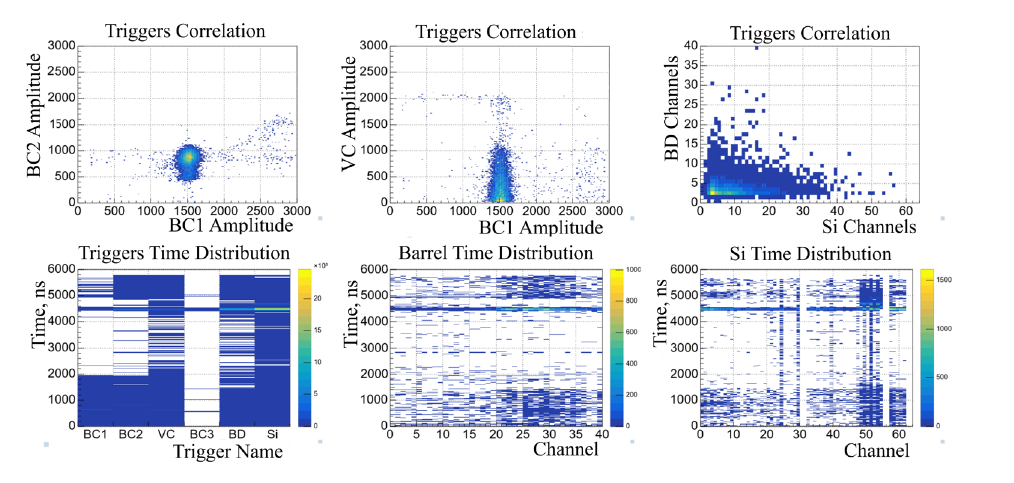
Figure 2. Example of the monitoring histograms. On the first line one can see the correlation plots of the corresponding beam counters. On the second line there are time distribution plots: several triggers vs time, Barrel Detector by channels vs time and Si Trigger by channels vs time